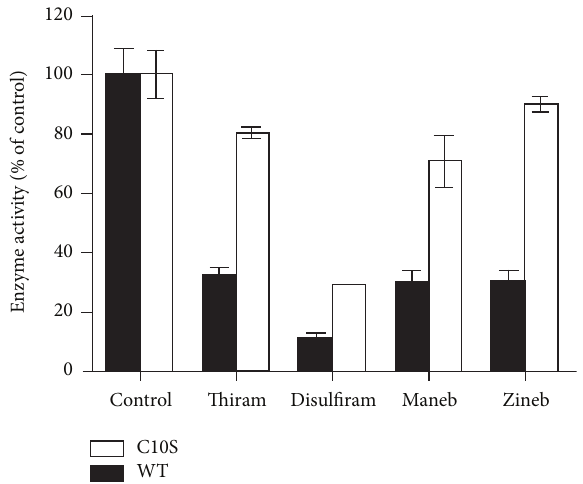
Figure6:Inhibitionof17 𝛽 -HSD1andCys 10 Sermutantbydithiocar- bamate chemicals. The conversion of estrone (200nM) to estradiol in the presence of 400 𝜇 M NADPH and various dithiocarbamates (80 𝜇 M final concentration) was measured in lysates of transfected HEK-293cells.Blackbars,wild-type17 𝛽 -HSD1enzyme(WT);white bars,Cys 10 Sermutant17 𝛽 -HSD1(C10S).Theamountoftotalprotein inthereactionwasequalizedtoexcludedifferencesduetounspecific binding of the inhibitors to cellular